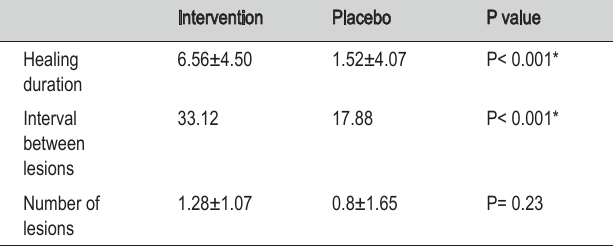
Table 3 - Comparison of number of lesions, healing duration